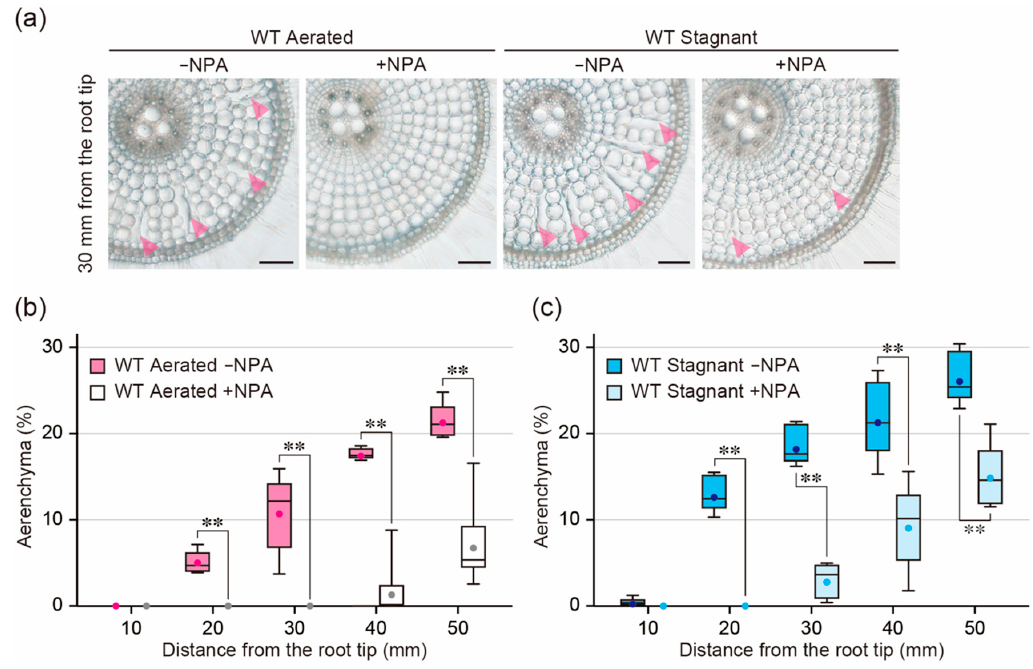
Figure 4. Aerenchyma formation under aerated or stagnant conditions with or without N -1-naphthylphthalamic acid (NPA) treatment. ( a ) Cross-sections at 30 mm from the tips of adventitious roots of the wild type (WT). Aerenchyma is indicated by magenta arrowheads. Bars = 100 µ m. ( b , c ) Percentages of aerenchyma in root cross-sectional area at 10, 20, 30, 40, and 50 mm. Twenty-day-old aerobically grown WT seedlings were further grown under aerated ( b ) or stagnant ( c ) conditions with or without 0.5 µ M NPA for 48 h. ( b , c ) Significant di ff erences between the conditions at p < 0.01 are denoted by ** (two-sample t -test). Boxplots show the median (horizontal lines), 25th to 75th percentiles (edges of the boxes), minimum to maximum (edges of the whiskers) and mean values (dots in the boxes) ( n = 6).